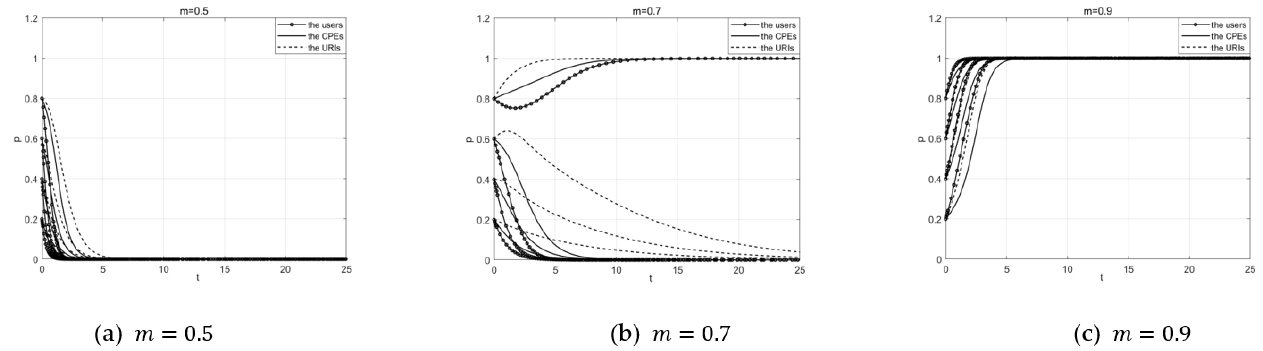
Figure 7. Impact of cost compression coefficient on the strategies of the Users, the CPEs and the URIs, and ( a – c ) show the evolution of the tripartite strategies under different values of 𝑚 . The cost compression coefficient can be understood as “the degree of cooperation”.